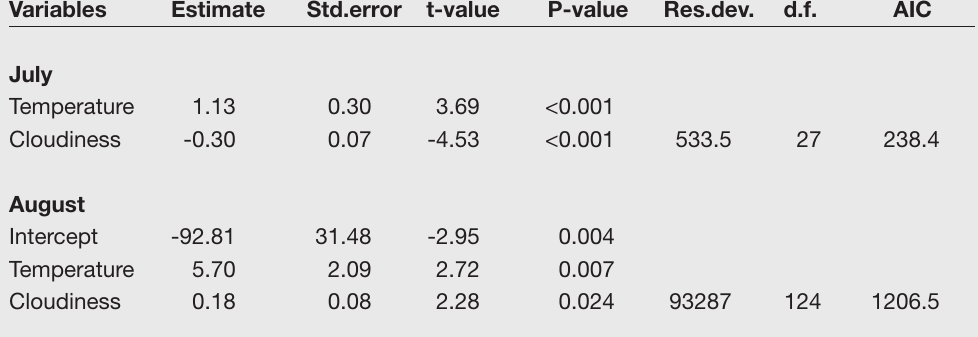
Table 1. Summary statistics of the GLM analysis. The residuals from the cos model were used as response variable and the metrological data (see text) as predictors. The significant variables were selected using forward selection. Res.dev. is the residual